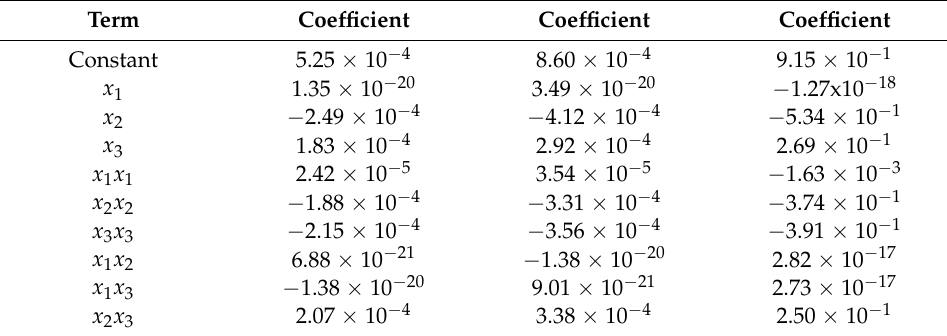
Table 9. Estimated regression coefficient for refined palm